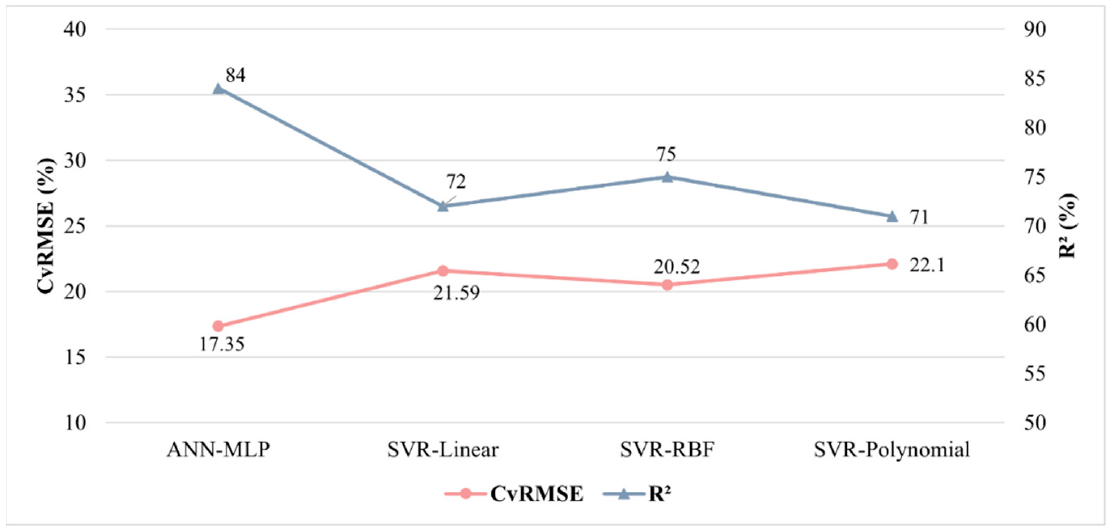
Figure 10. Comparison of the CvRMSE and R 2 for each electricity consumption prediction model.